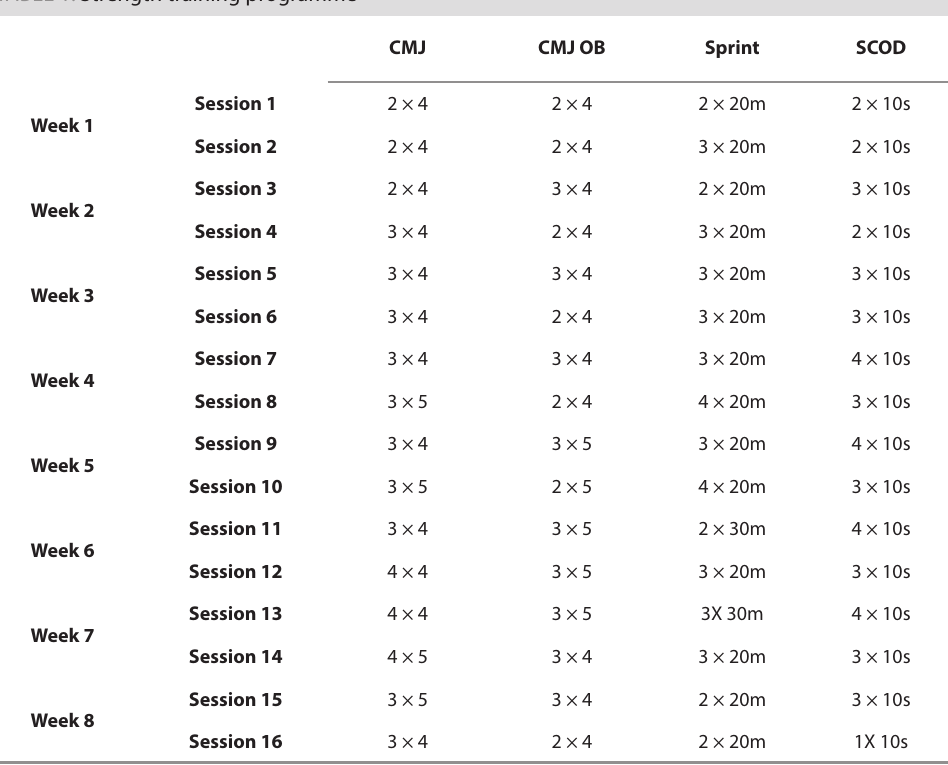
Note. CMJ – counter-movement jump, CMJ OB– counter-movement jump onto a box, SPRINT –